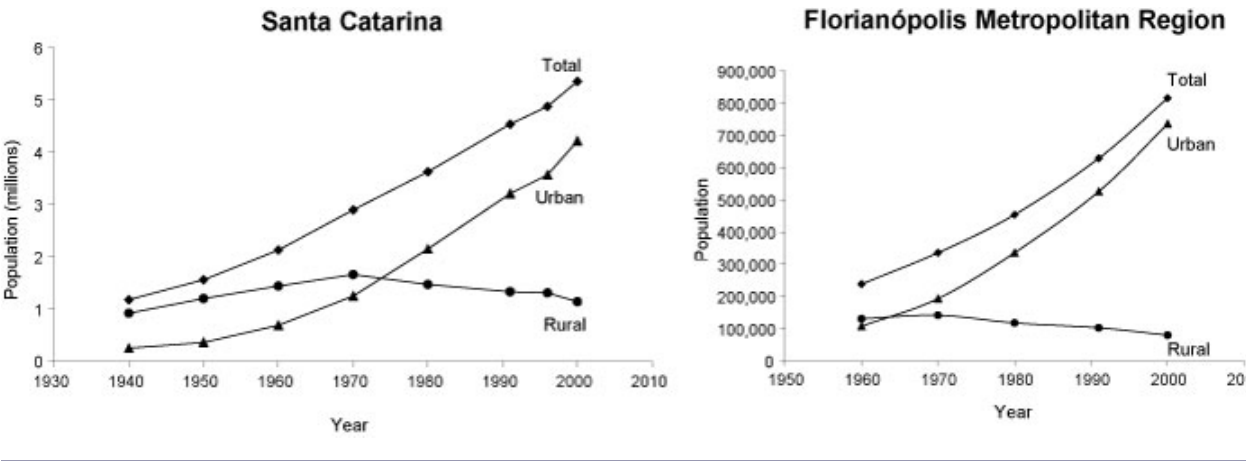
Fig. 4. Demographic trends in Santa Catarina and the Florianópolis metropolitan region.